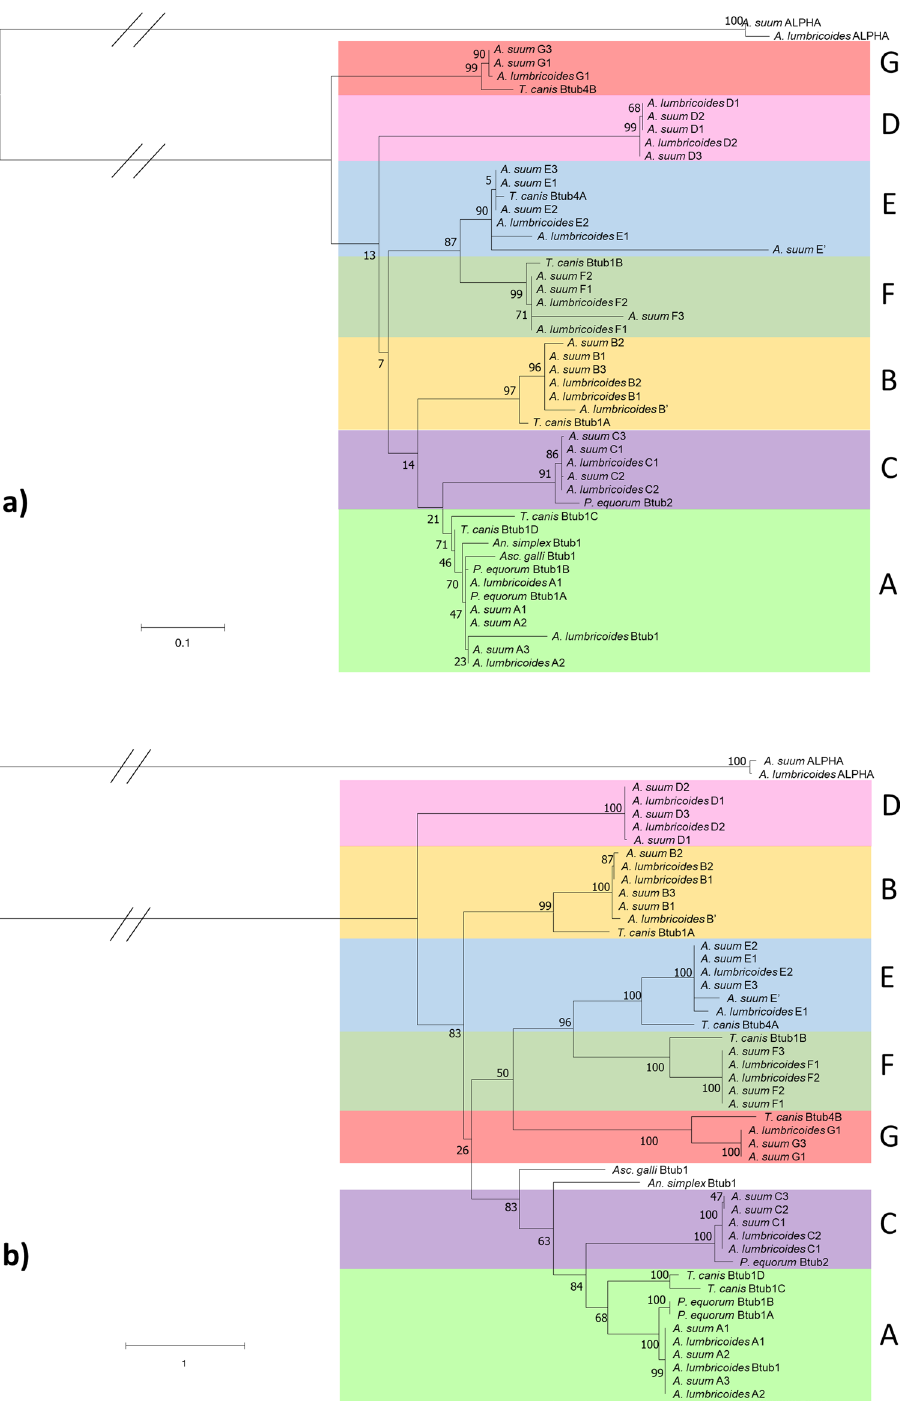
Figure 1. Phylogenetic reconstruction of Ascaridomorpha β-tubulins. Phylogenies show the relationship between each isotype from the Ascaris genomes as well as previously published Ascaridomorpha species β-tubulins. ( a ) Shows the phylogeny reconstructed using the peptide sequences under the assumptions of the JTT + G model. ( b ) Shows the nucleotide phylogeny reconstructed under the K2 + G + I model. Both phylogenies underwent 1000 bootstraps. Bootstrap values are shown at each node. Sequences collected for members of the Ascaridomorpha have retained the nomenclature given in the database (e.g., Toxocara canis β-tub4B). The species included were Anisakis simplex , Ascaridia galli , Parascaris equorum and Toxocara canis . For the Ascaris sequences identified from the genomes each sample is named by species, isotype and then genome number (e.g., Ascaris suum C3 is the isotype C sequence from A. suum genome